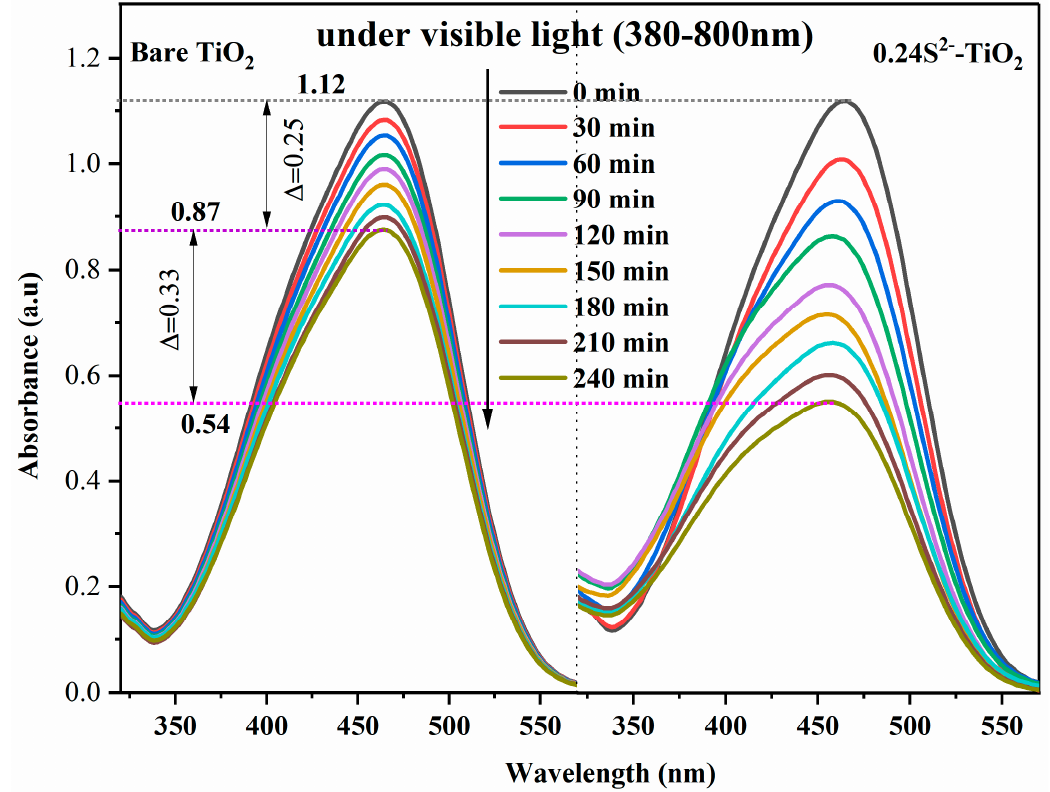
Figure 9. UV-Vis absorption spectral curves of by bare TiO 2 and 0.24S 2 − -TiO 2 in visible light degraded MO solution.